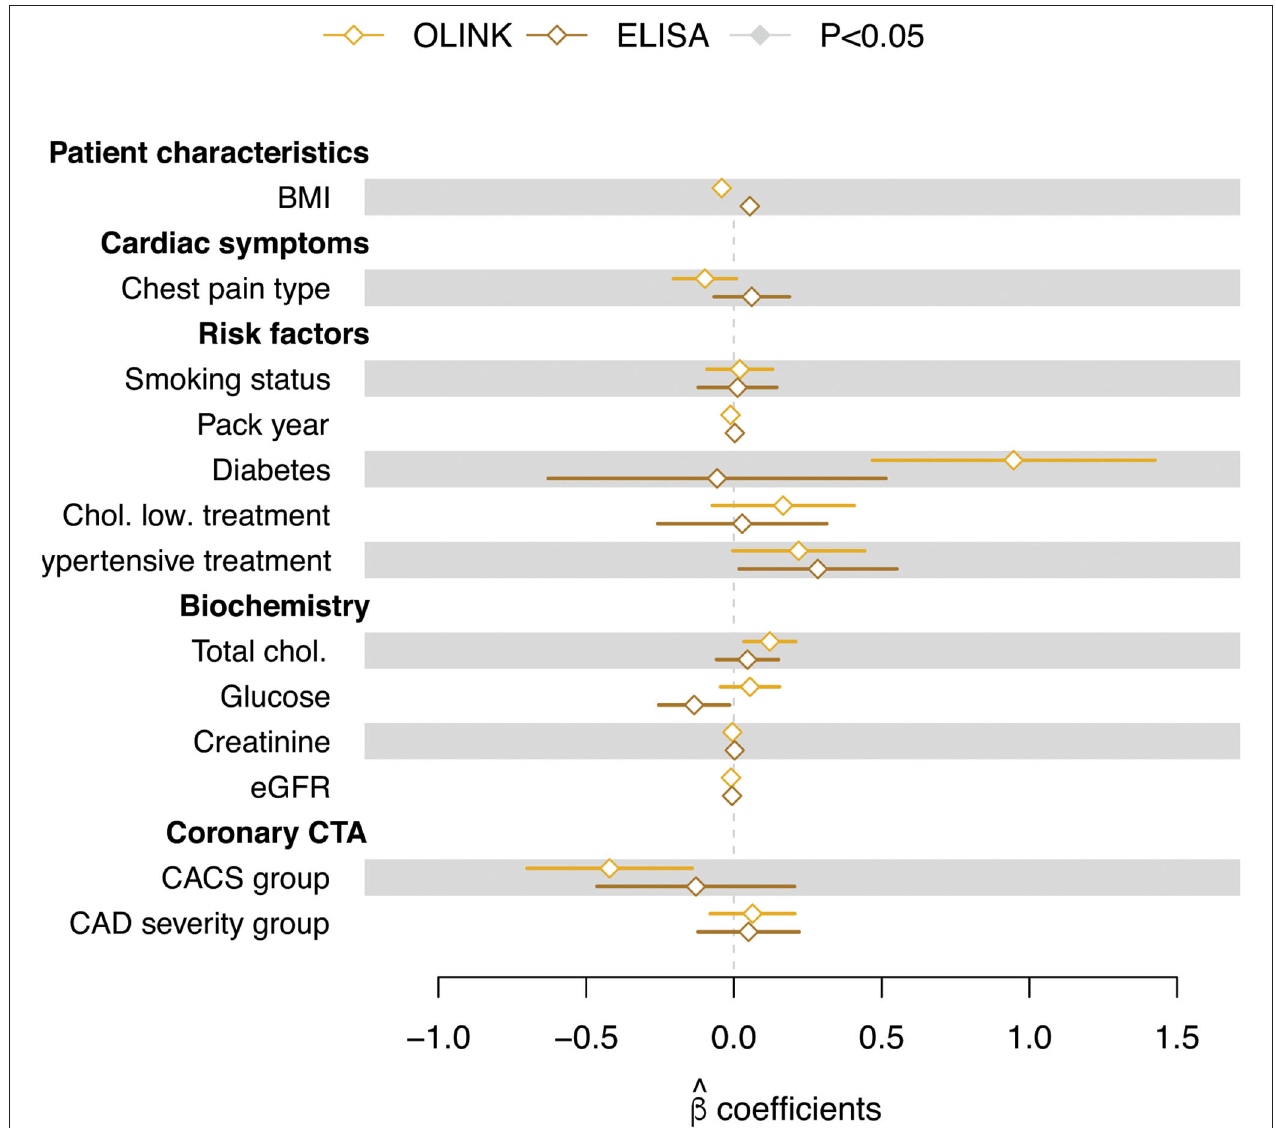
FIGURE 4 | Regression coefficients ( β estimates) from multiple linear regression of circulating sortilin (adjusted values) measured with OLINK and ELISA technologies. Error bars indicate the standard error on the estimate. Filled symbols indicate that the β estimates are significantly different from zero.